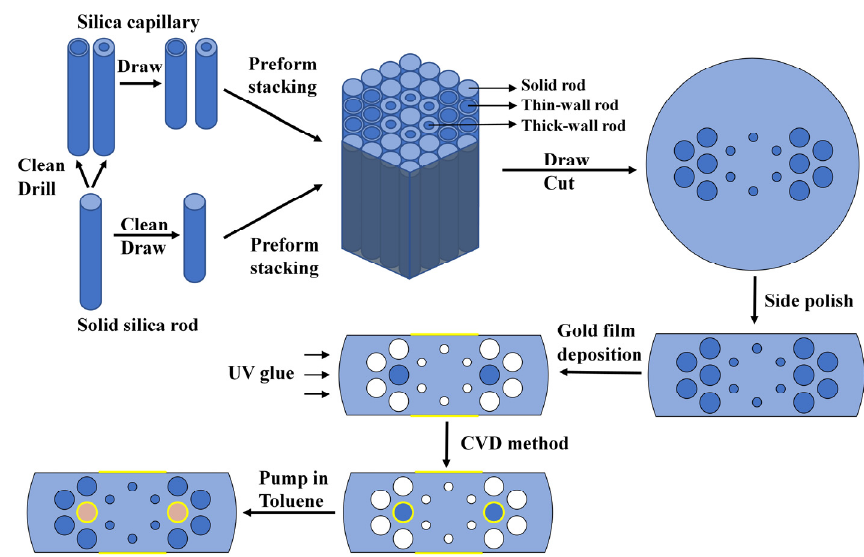
Figure 15. Manufacturing process of the proposed flat PCF plasmonic sensor.